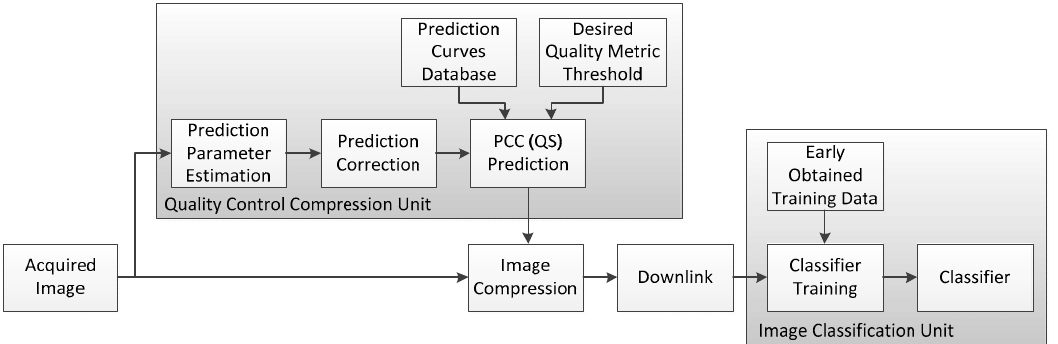
Figure 13. Flowchart of the proposed processing approach.